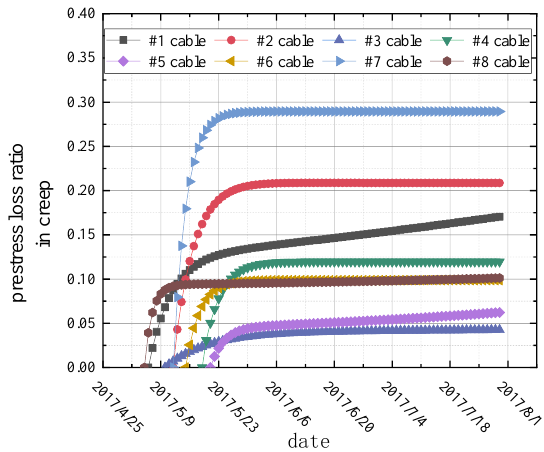
Figure 13. The curves of creep prestress loss ratio with time.